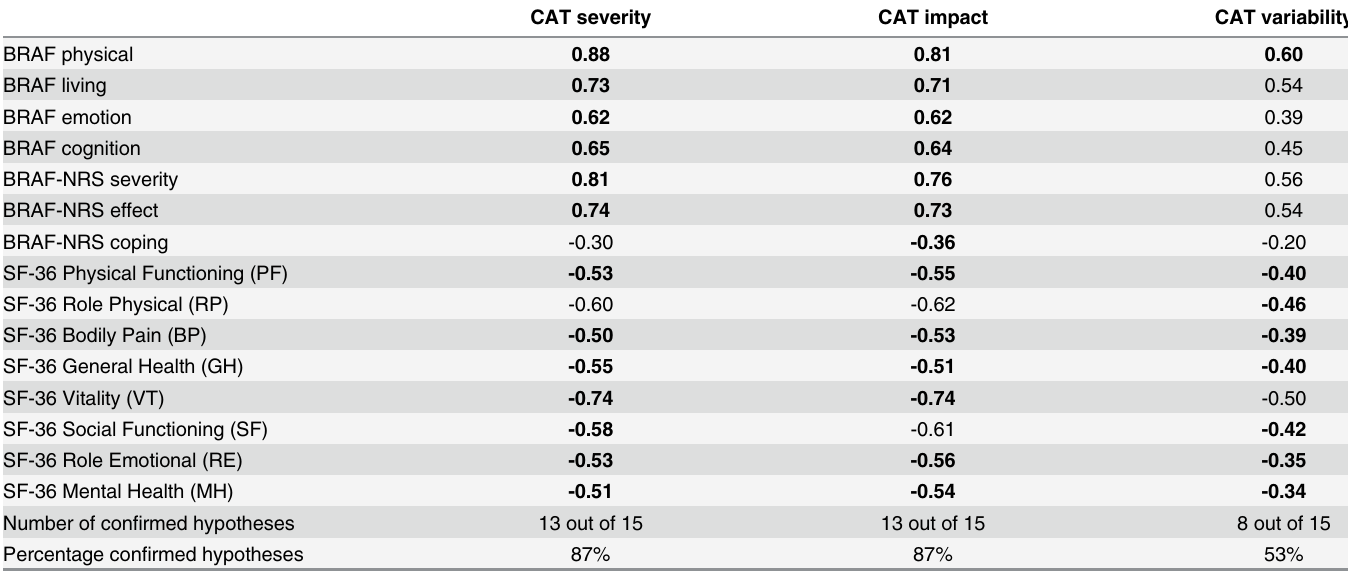
Table 4. Correlations CAT with BRAF-MDQ, BRAF-NRS and SF-36.